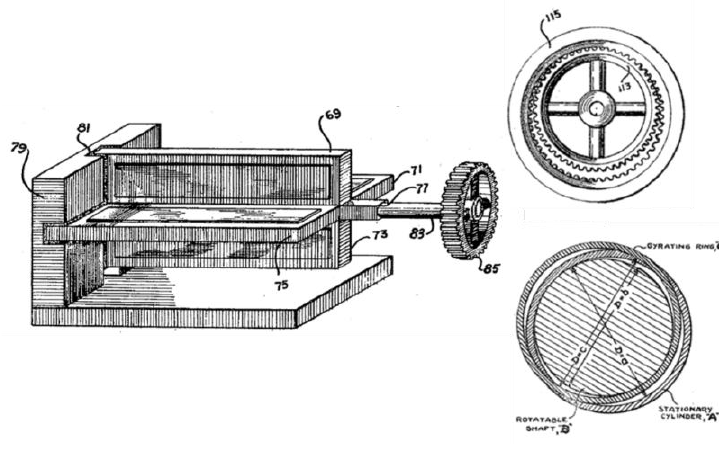
Figure 2. Piezoelectric motor proposed by Williams et al. in 1942 [2].